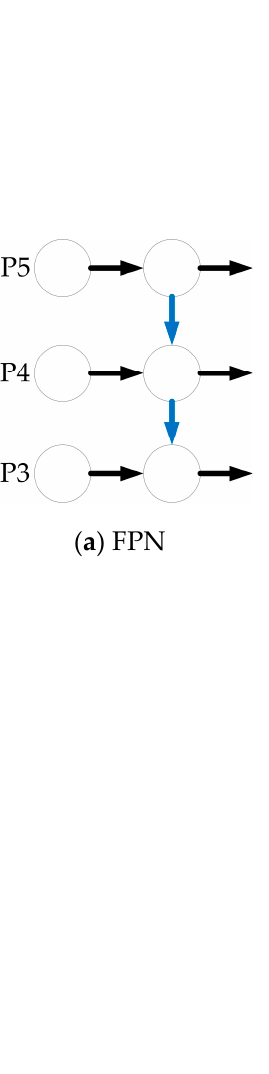
Figure 10. MS-YOLOv5s network architecture.